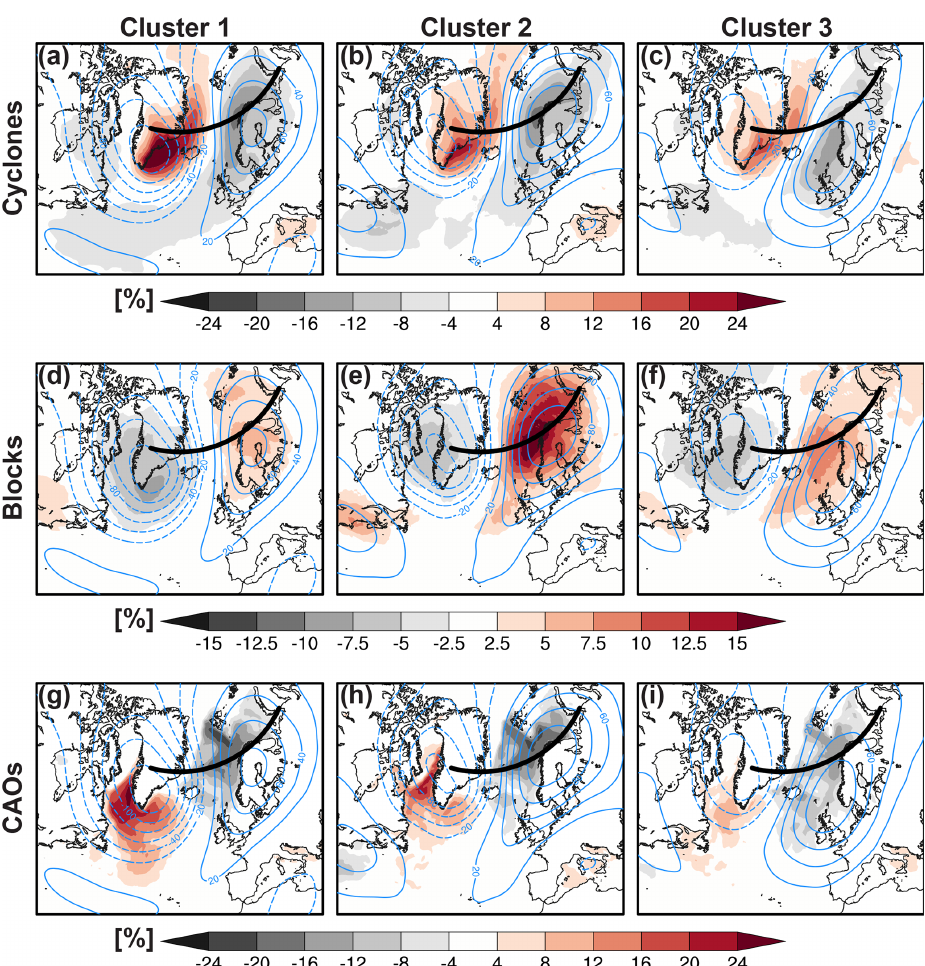
Figure 10. Composites of (a–c) cyclone, (d–f) blocking, and (g–i) cold air outbreak frequency anomalies relative to climatology during the 3d prior to moist-air intrusions in the North Atlantic in clusters (a, d, g) 1, (b, e, h) 2, and (c, f, i) 3. Blue contours indicate corresponding 500hPa geopotential height anomalies in intervals of 20m, with negative values dashed and the zero contour